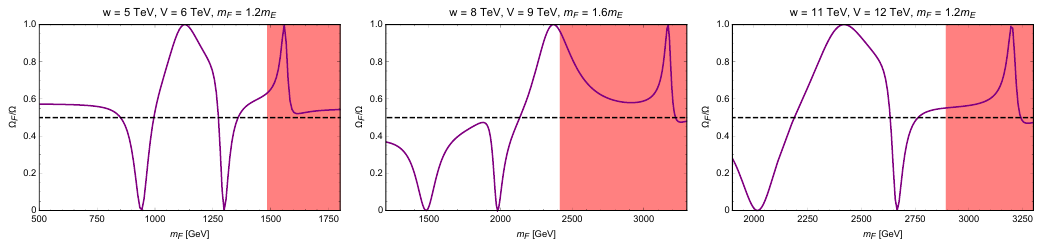
Figure 6 . The contribution ratio of fermion dark matter components to the density as a function of dark matter masses for the case m F > m E